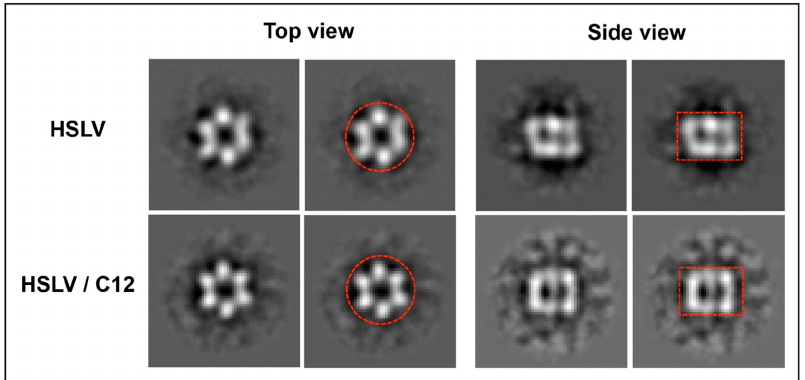
Figure 7. Comparison of LmHslV and LmHslV-LmC12-U2 class averages corresponding to top and side views. Top and side views of HslV and HslV-LmC12-U2 are displayed separately in two panels. In each panel, the first row corresponds to the original class averages while the second row corresponds to the same class average superimposed either by a round circle of 12.5 nm diameter or a rectangle of 12.2 nm × 8.8